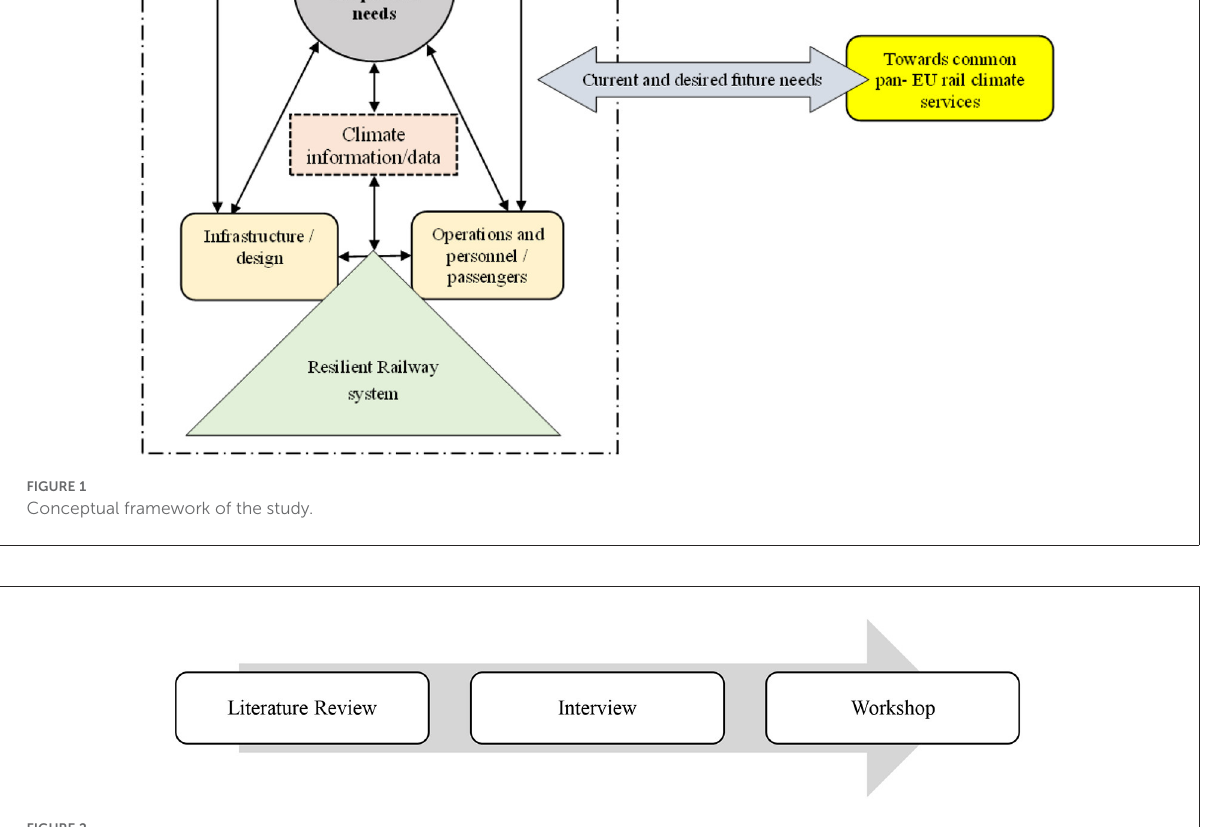
FIGURE2 Methodology of the